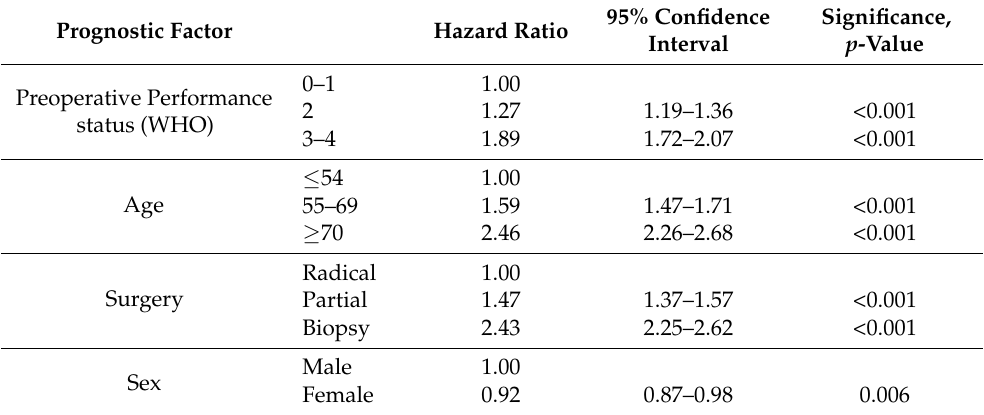
Table 3. Multivariate analysis including the prognostic factors; preoperative performance status (PPS), age, type of surgery, and